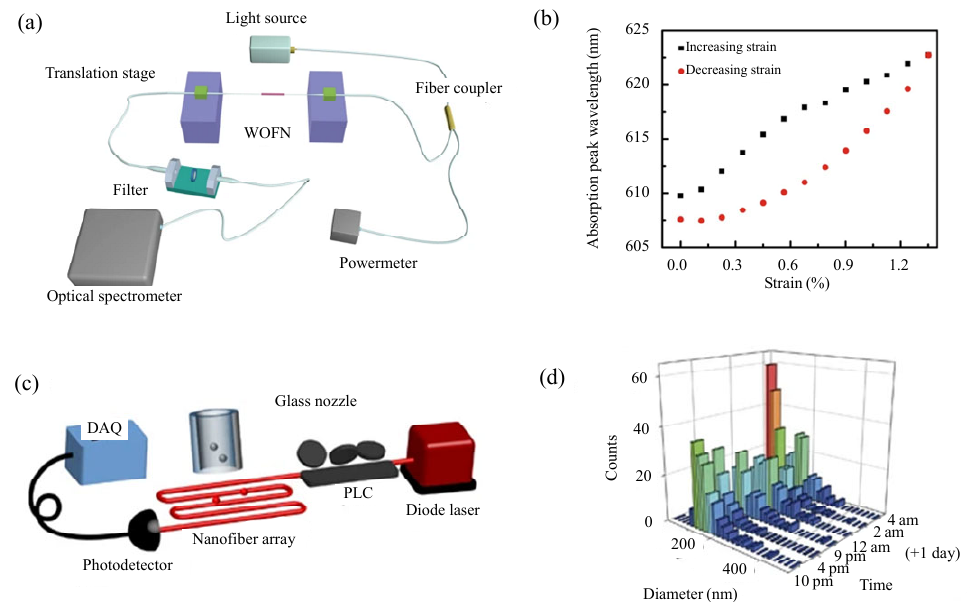
Fig. 11 Loss-based microfiber sensors: (a) experimental setup for in-line strain manipulation of absorption spectra of monolayer WS 2 to an optical fiber nanowire (WOFN). Reproduced with permission [170]. Copyright 2019 Springer Nature; (b) absorption peak wavelength of the WOFN with the increase and decrease in the strain. Reproduced with permission [170]. Copyright 2019 Springer Nature; (c) schematic setup of a Rayleigh-Gans-scattering-based nanofiber array size spectrometry. DAQ, data acquisition system; PLC, polarization controller. Reproduced with permission [235]. Copyright 2018 Springer Nature; (d) size histogram of nanoparticles in six air samples collected from different moments, evaluated by the nanofiber array size spectrometer. Reproduced with permission [235]. Copyright 2018 Springer